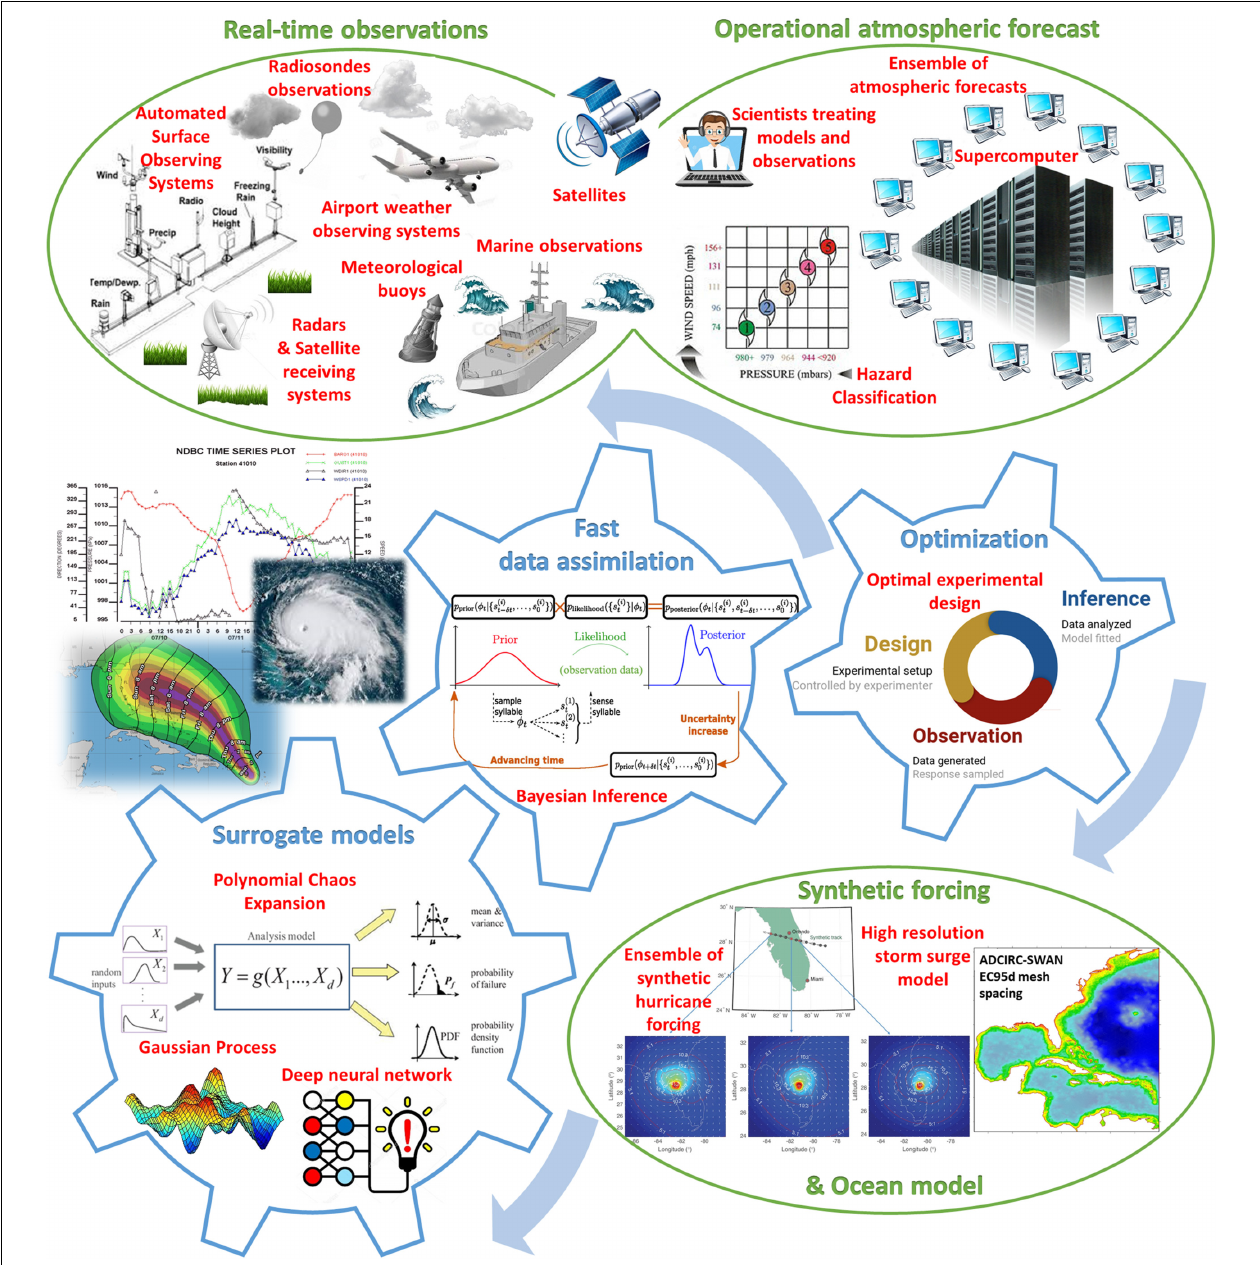
FIGURE 2 | Proposed conceptual design for early warning systems illustrated for hurricanes in the Gulf of Mexico and the US East Coast. The three blue wheels represent the uncertainty quantification and optimization tools including the surrogate models, the fast data assimilation and the optimal experimental design. The green ellipses show the input needed to build (bottom right, the synthetic forcing and the ocean model) and run (top, real-time observations and operational atmospheric forecast) the early warning